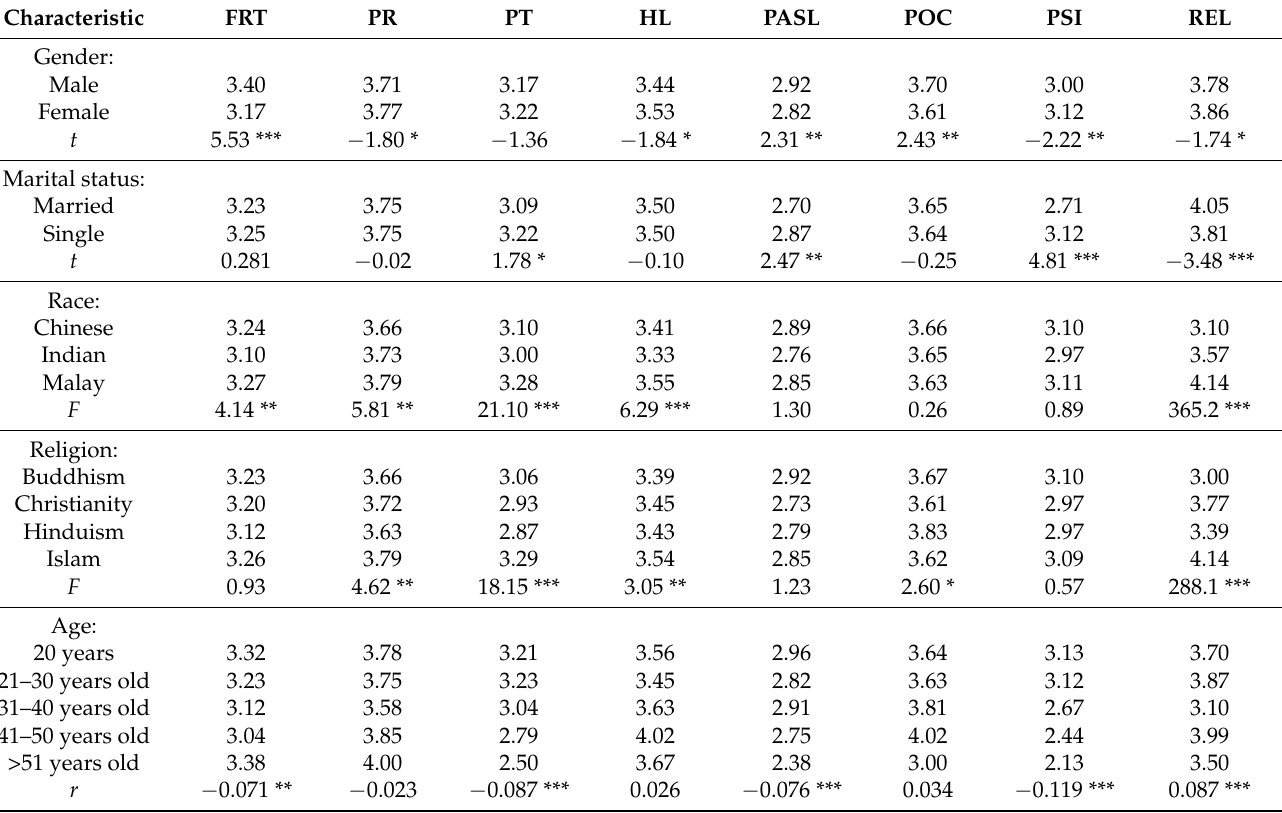
Table 5. Mean scores and effects for each variable by gender, marital status, race, religion, and